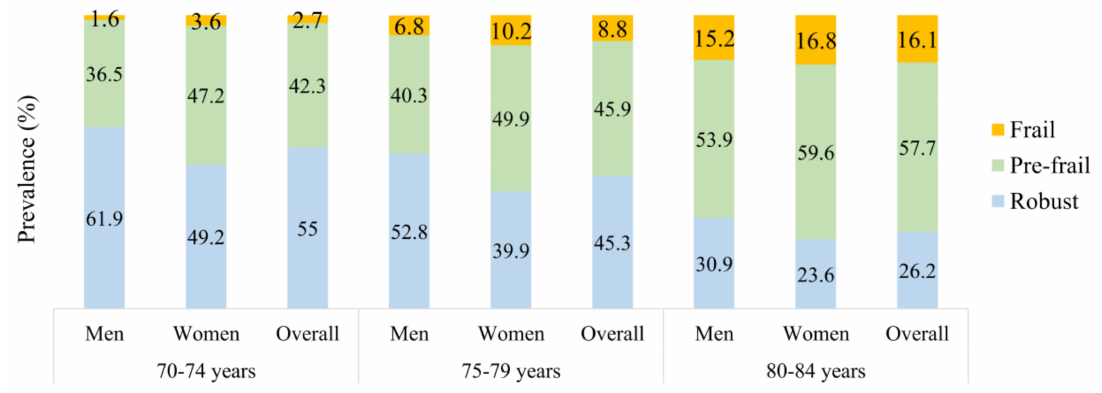
Figure 1. Prevalence of frailty with age groups (standardized